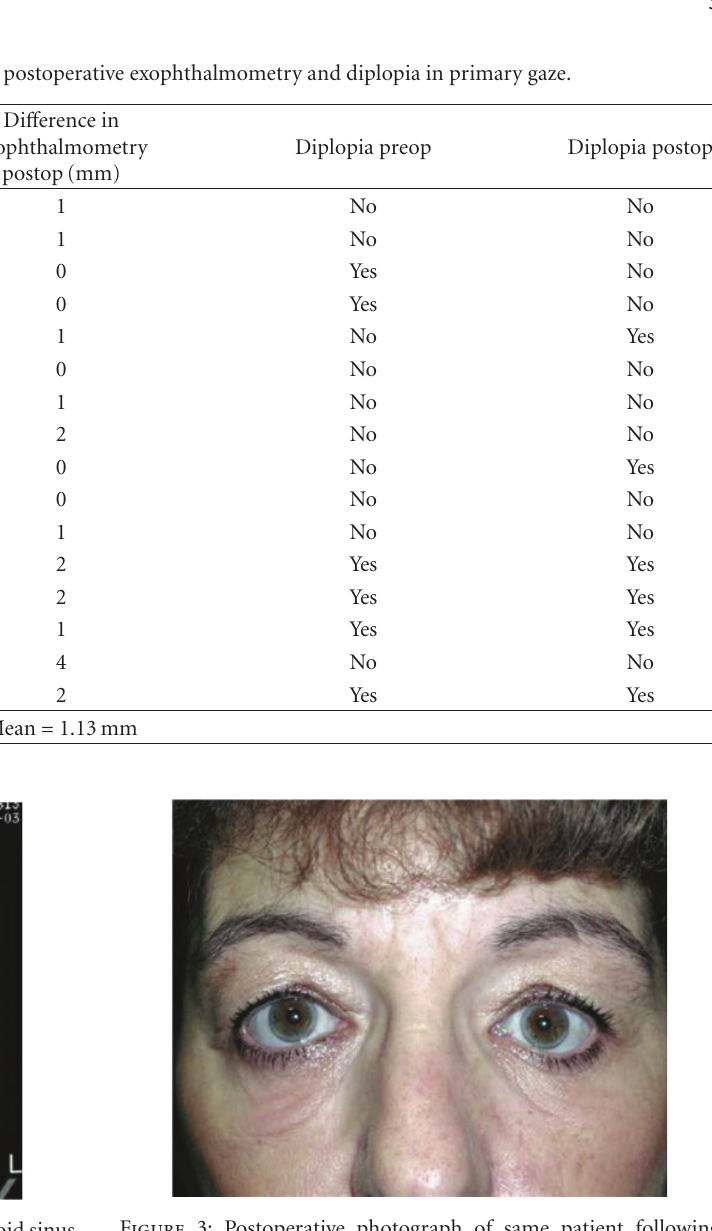
Figure 1: Coronal CT scan shows fat herniation into ethmoid sinus after transcaruncular medial wall orbital decompression.